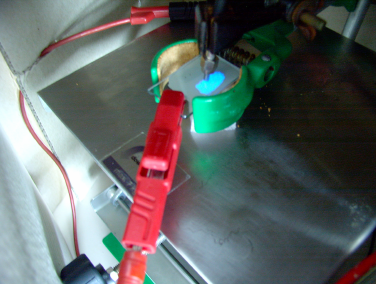
Figure 11 . AC-luminescence after heat treatment at 500 – C; light taken up by a fibre spectrometer.